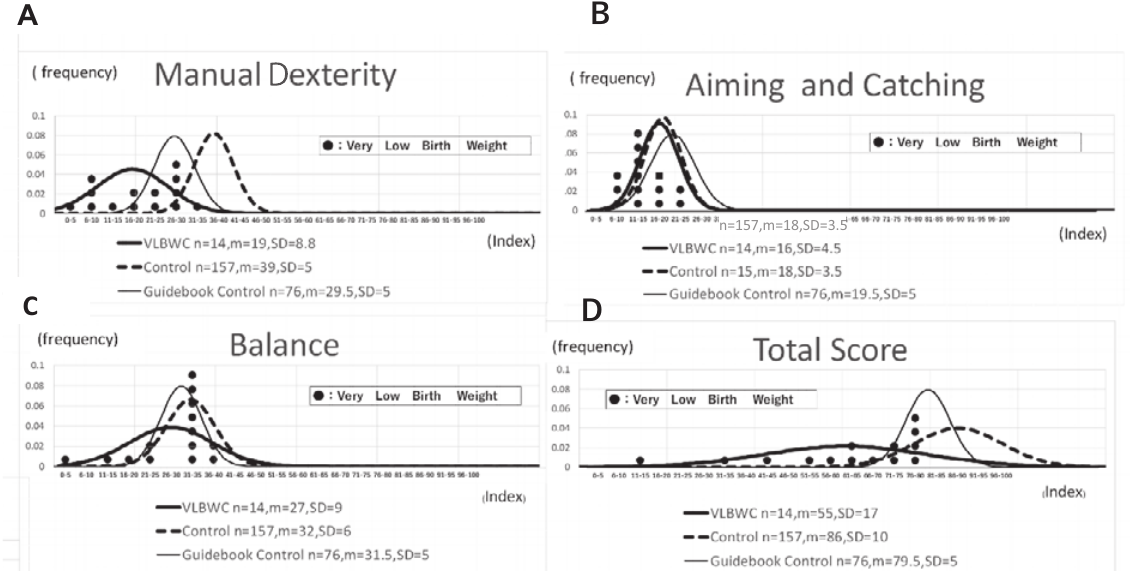
Figure 2. This showed the result of MABC-2. Normal distribution of index for 6-year-old very low birth weight children (VLBWC), controls, and guidebook control. Each dot shows the individual index of MABC-2 in VLBWC subjects.